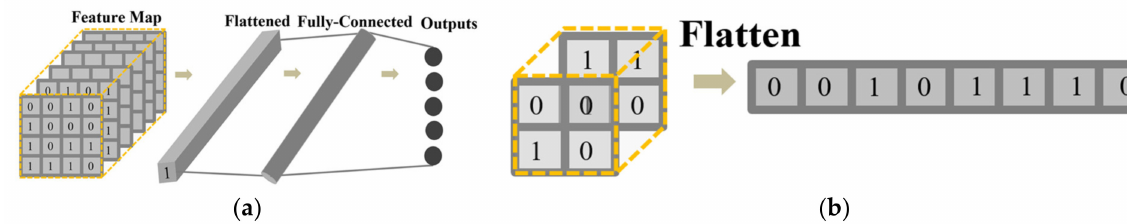
Figure 11. ( a ) Feature mapping and classification layer. ( b ) The way the feature flattens